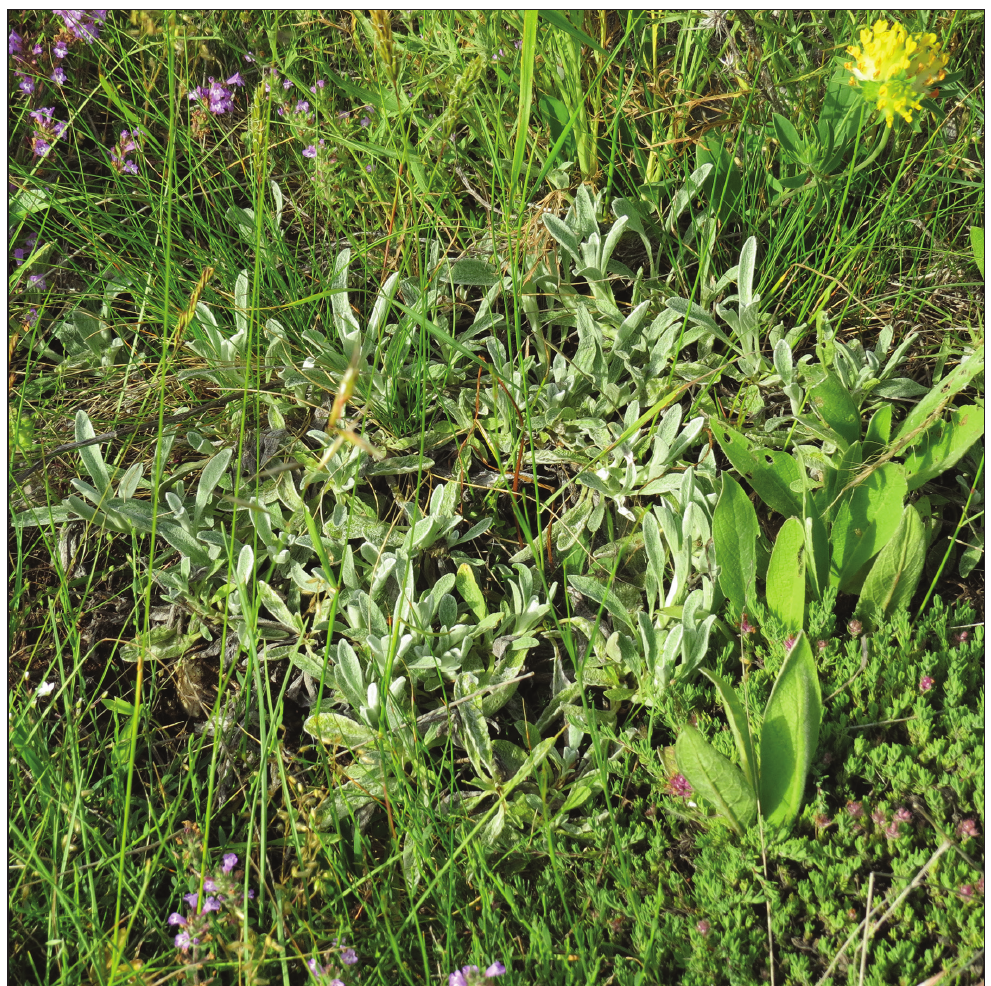
Figure 11. Helichrysum vegetation in Galičica National Park.